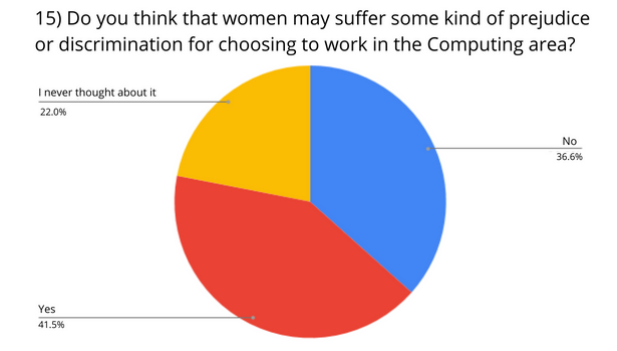
Figure 6. Graph of the responses from the Database workshop to the question “Do you think that women may suffer some kind of prejudice or discrimination for choosing to work in the Computing area?” .